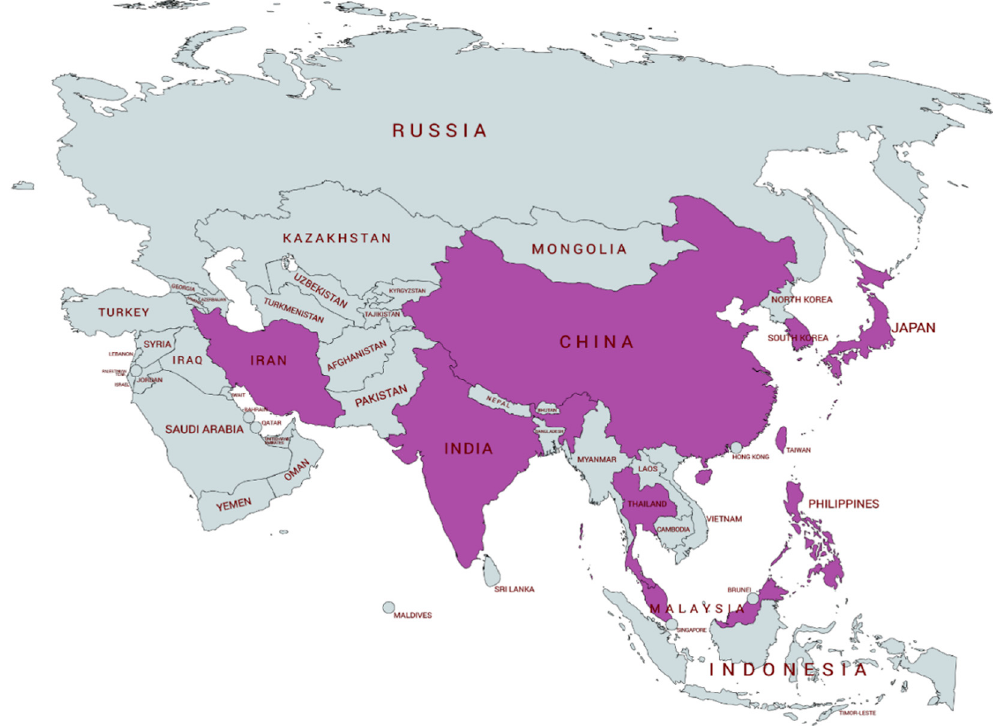
Figure 1. Distribution of APP, PSEN1, and PSEN2 mutations in Asian countries . The fastest increase in the number of elderly individuals has been observed in Asian countries with approximately 60% of all patients diagnosed with dementia. The countries from which the gene mutations are reported are shown in purple.